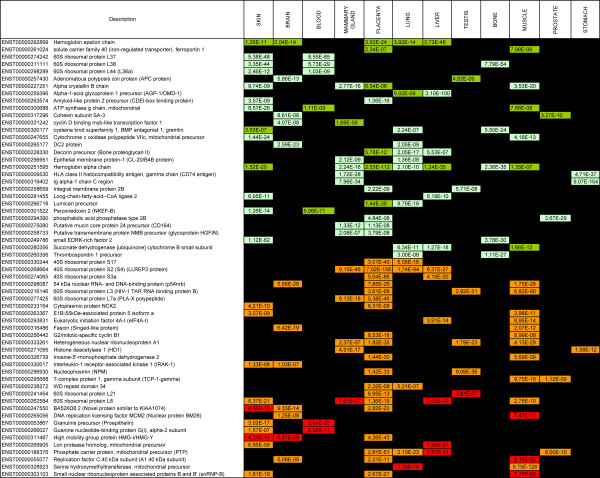
Genes whose transcripts varied significantly and consistently in abundance in at least two different tissues. Thirty genes were selected in each class of differential expression (upregulated, downregulated, tumor-specific or absent in tumors). The results are shown for twelve tissues. The legend is the same as in Figure 1. See additional information for the full data.